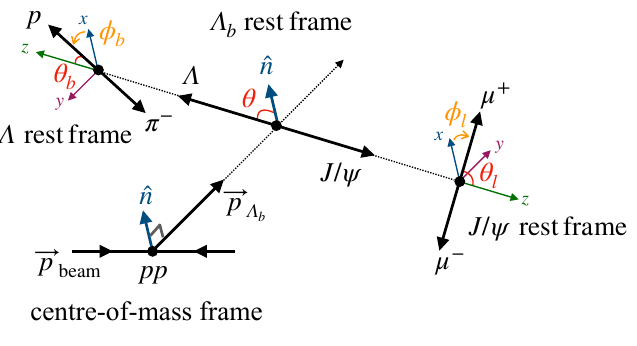
Figure 1 . De(cid:12)nition of the (cid:12)ve decay angles, (cid:18) , (cid:18) b , (cid:30) b , (cid:18) l and (cid:30) l used to describe the kinematics of the (cid:3) 0 ! J= (cid:3) decay. The angles are described in the b